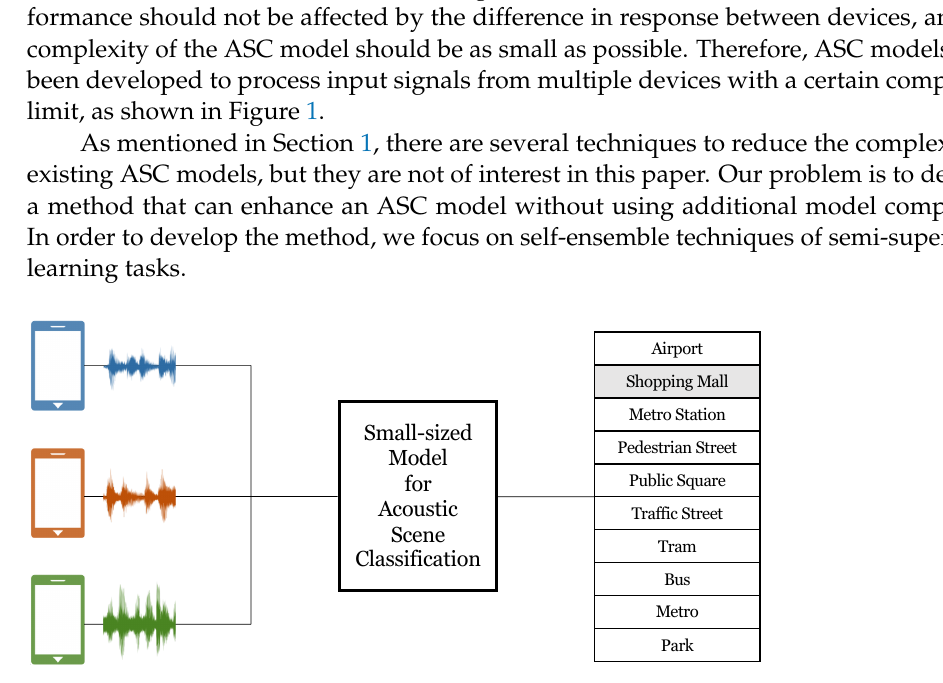
Figure 1. Problem description for the model-complexity-limited acoustic scene classification (ASC)